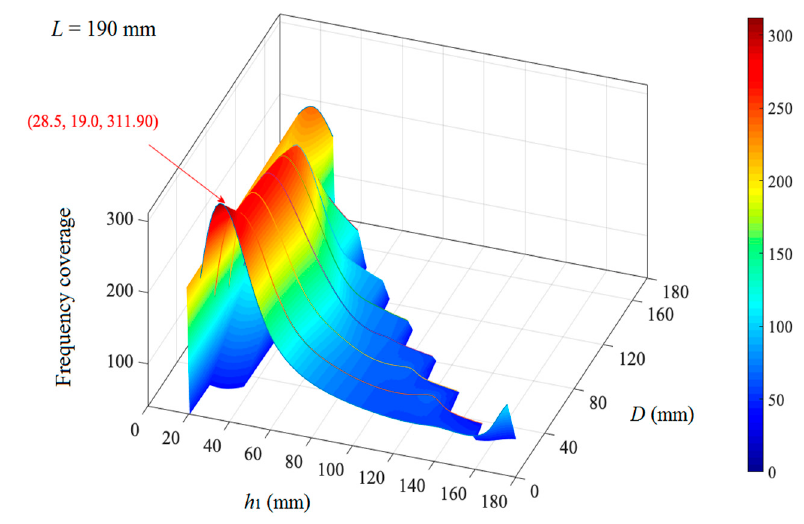
Figure 10. The frequency coverage of the triple-layer MPPs at L = 190 mm.